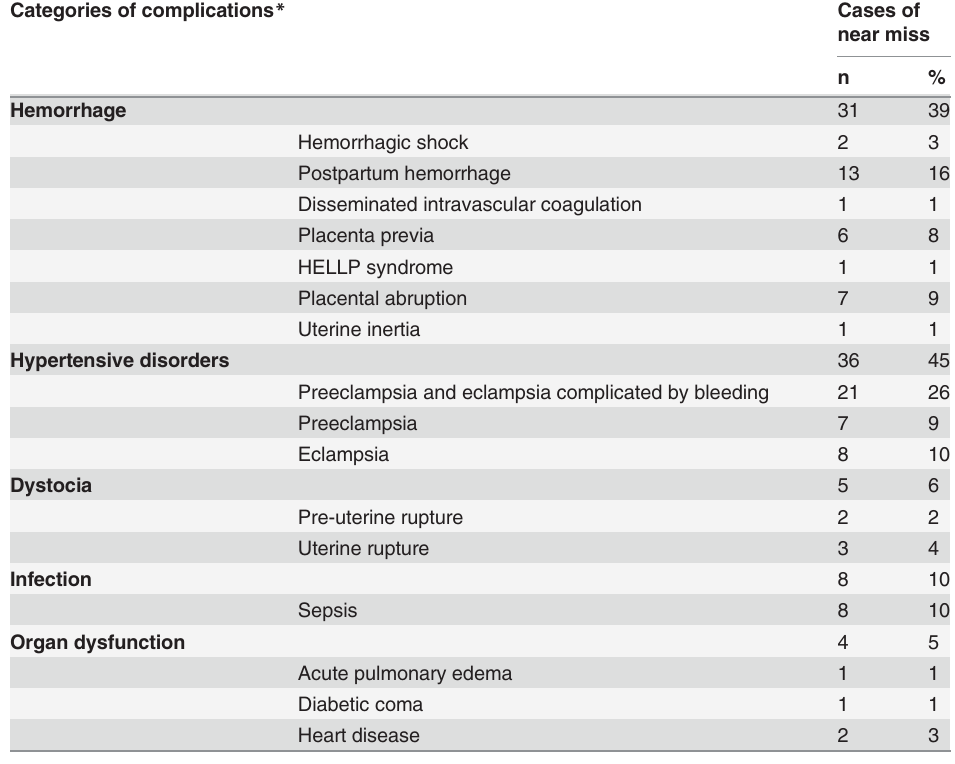
Table 5. Distribution of near-miss